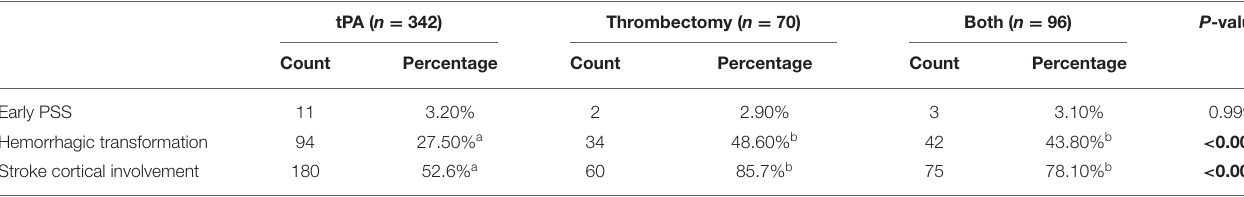
Hemorrhagic transformation < 0.001 The bold values represent p-values that reached statistical significance. TABLE 2 | Rates of early PSS, hemorrhagic transformation, and stroke cortical involvement in each treatment group. tPA ( n =